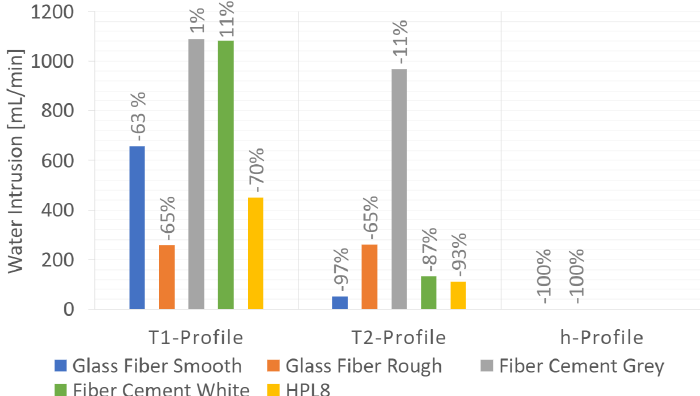
Figure 10. Water intrusion to the interior side of the panels when profiles within the joint were used: T1-, T2-, and h-profiles. The percentage change from the water intrusion measured with the standard recommendations in Table 3 is shown.